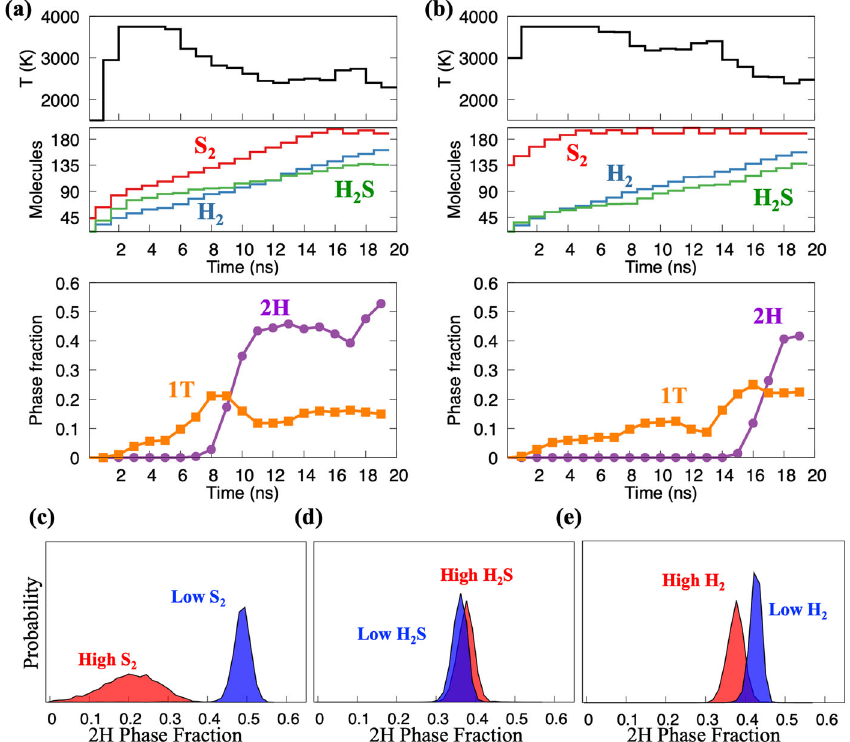
Fig. 4 Effect of synthesis conditions on products. a A generated synthesis pro fi le starting from low temperature and low gas concentrations. The RL model quickly ramps up the temperature up to 7 ns to promote reduction and sul fi dation and then lowers the temperature to intermediate values to promote crystallization. This pro fi le generates signi fi cant phase fraction of 2H starting from 10 ns. b A generated synthesis pro fi le starting from high temperature and high S 2 concentrations. The RL-NADE model retains the high temperature at early stages of synthesis and slowly anneals the system to intermediate temperatures after 10 ns. This schedule promotes relatively late crystallization and 2H phase formation. c Synthesis pro fi les with initially low S 2 concentrations yield signi fi cantly higher phase fraction of 2H in the fi nal product compared to pro fi les containing higher S 2 concentrations at t = 0 ns. d , e Synthesis schedules are relatively insensitive to the initial concentration of reducing species, H 2 S and H 2